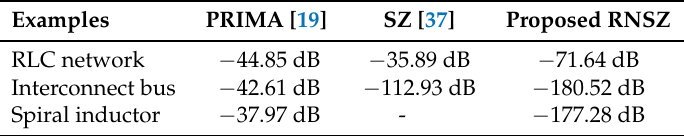
Table 1. Mean absolute error comparison for various